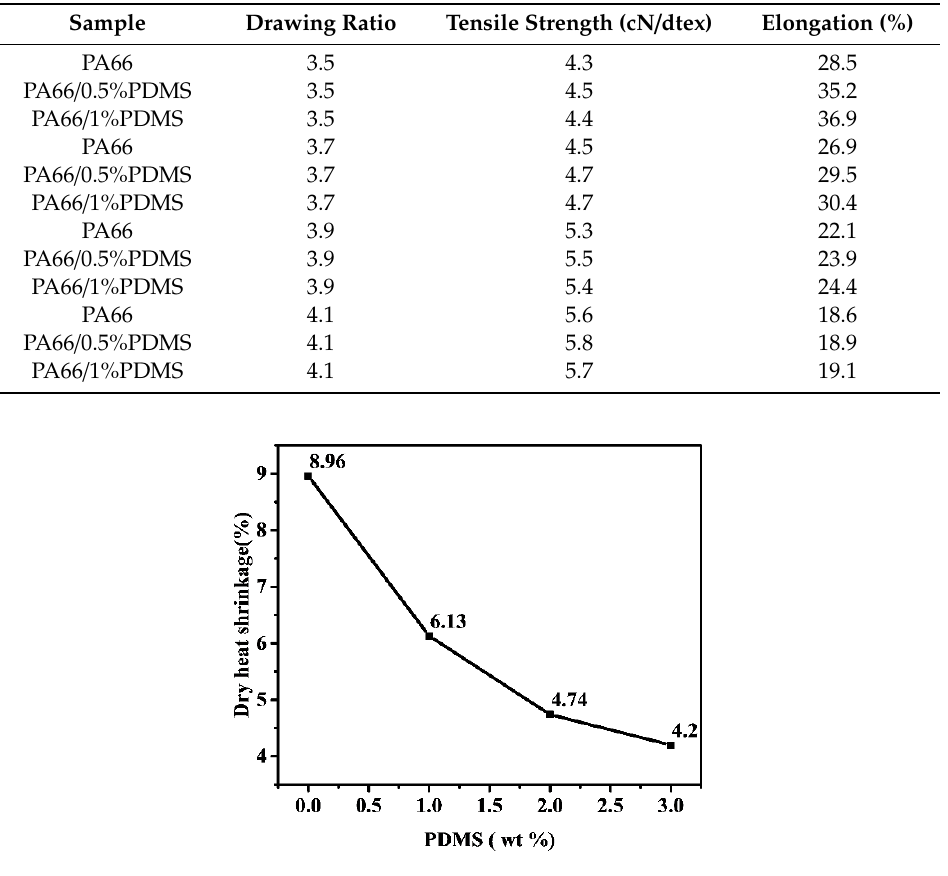
Figure 3. Correlation between dry heat shrinkage and PDMS content. Table 1. Tensile strength and elongation of PA66/PDMS blend fibers with different addition of PDMS at varied drawing ratio.